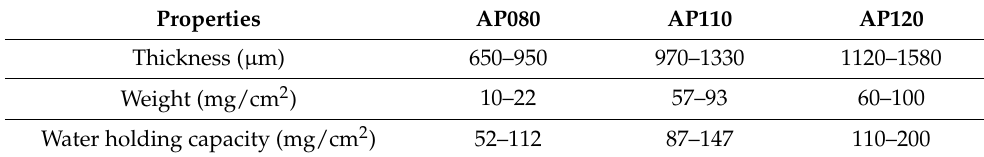
Table 1. Physical and performance characteristics of different types of absorbent